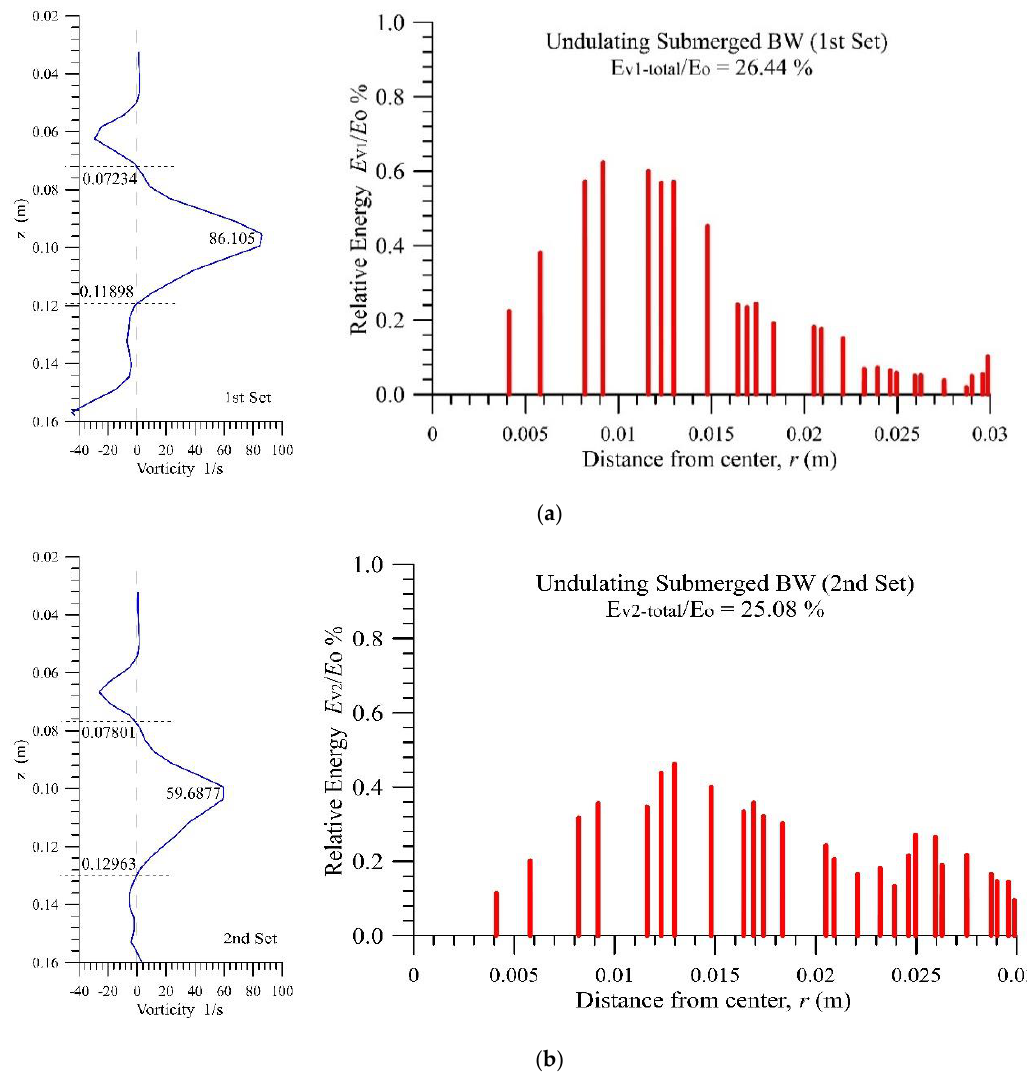
Figure 14. The vorticity distribution along the vertical line of the vortex center and relative vortex energy distribution of the maximum vortex induced by a solitary-like wave propagating over ( a ) the first set and ( b ) the second set of a composite set of undulating submerged breakwaters.